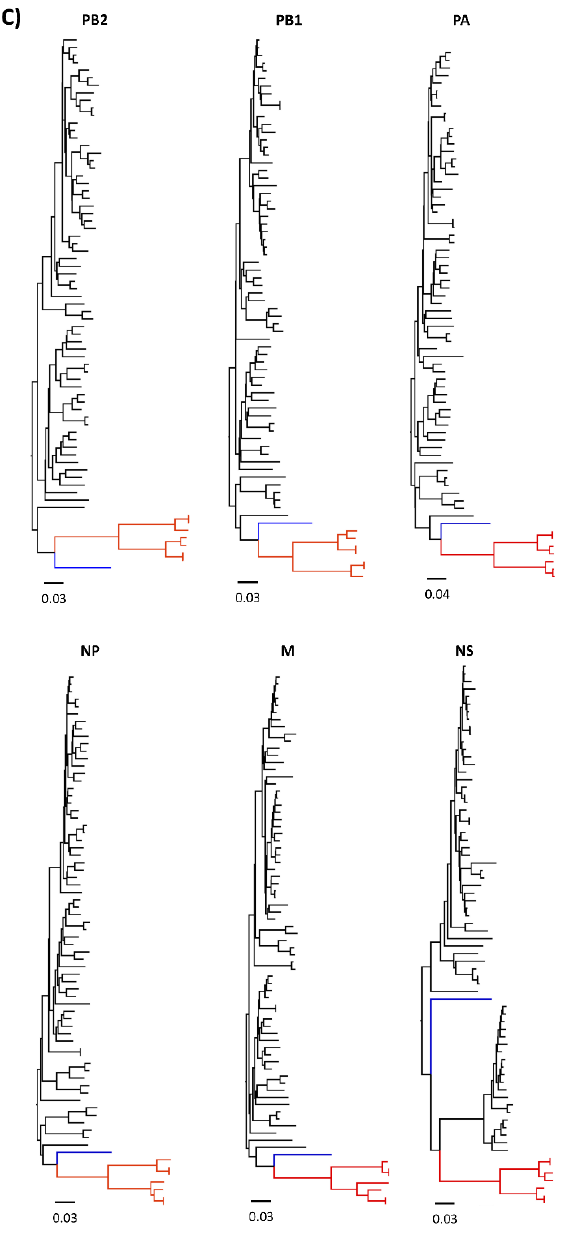
Figure 1. Phylogenetic trees of bat influenza virus genes. ( A ) Phylogenetic tree of HA gene. ( B ) Phylogenetic tree of NA gene. ( C ) Phylogenetic trees of internal genes. We downloaded 70 full-length genome sequences from different subtypes of conventional influenza A viruses (IAVs) and eight bat influenza viruses, including 3 H17N10, 4 H18N11 and 1 H9N2-like bat viruses from public database. Phylogenetic analyses for each gene were performed based on their full-length gene sequences. The sequences were aligned by the MUSCLE method by MegAlign Pro 17. Phylogenetic relationships among bat HA and NA sequences with those from conventional IAVs were calculated using the maximum likelihood method by MegAlign Pro 17, while for the internal genes determined by using the Neighbor joining method by MegAlign Pro 17. Phylogenetic trees were visualized in FigTree (v1.4.3; http://tree.bio.ed.ac.uk/software/figtree/). Red color represents bat H17N10 and H18N11 viruses; blue color represents A/Bat/Egypt/381OP/2017 (H9N2) virus.